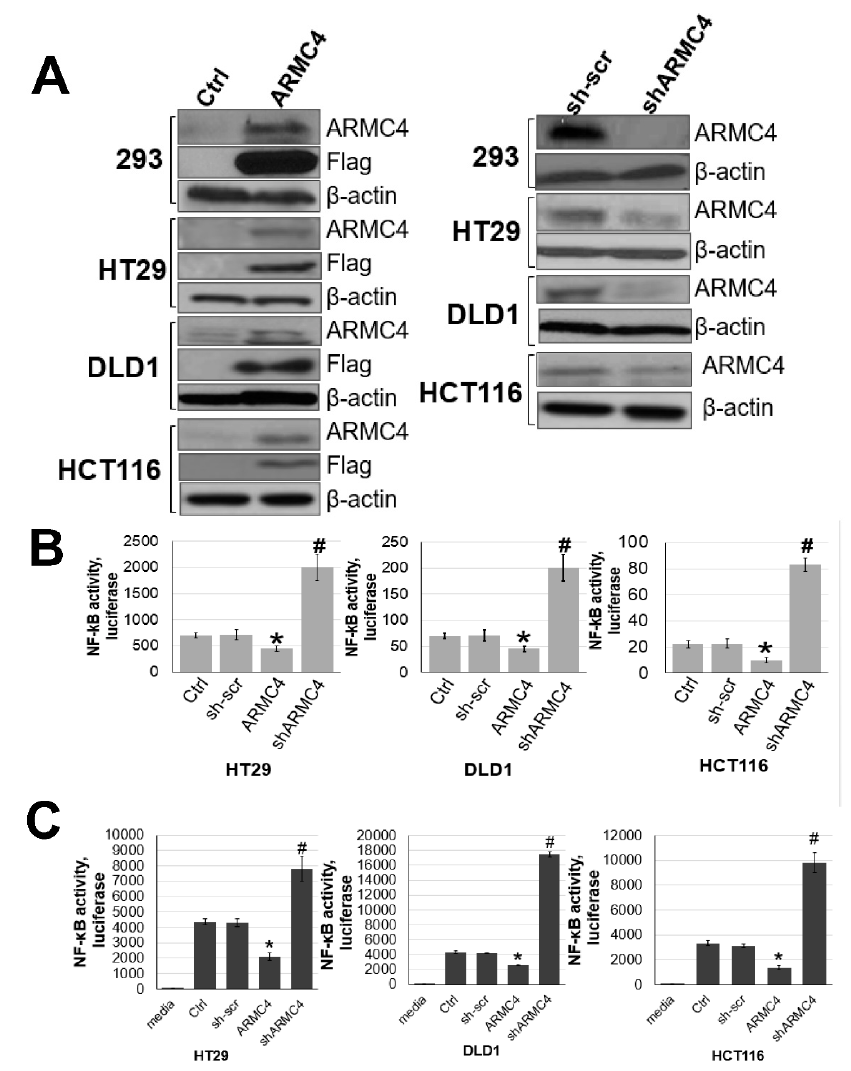
Figure 3. ARMC4 functions as a negative regulator of NF- κ B. ( A ) Western blot, showing that Flag- tagged ARMC4 was overexpressed in CRC cell lines HT29, DLD1, and HCT116 and HEK293 cells with the vector as the control (Ctrl) (left panel) and shARMC4 stable lines were also established with the sh-scramble (sh-scr) lines as the control (right panel). ( B ) NF- κ B luciferase assay, showing ARMC4 overexpression cells exhibited decreased NF- κ B activity compared to the Ctrl cells while the shARMC4 exhibited increased NF- κ B activity compared to the sh-scr. ( C ) Assays of conditioned media, showing that conditioned media from HT29, DLD1, and HCT116 cells overexpressing ARMC4 had much lower NF- κ B activation ability than vector ctrl cells. In contrast, conditioned media from shARMC4 knockdown cells in HT29, DLD1, and HCT116 cell lines had much higher NF- κ B activation ability than sh-scr cells. Stable 293-NF- κ B reporter cells were used to examine the media’s NF- κ B activation ability. The data were normalized to the total number of cells that generated the conditioned media and to the total amounts of protein. The data represent the means ± SD from three independent experiments. * p < 0.05 ARMC4 vs. Ctrl group; # p < 0.05 shARMC4 vs. sh-scr group. * p < 0.05 Ctrl vs. ARMC4 group; # p < 0.05 sh-scr vs. shARMC4 group; n =